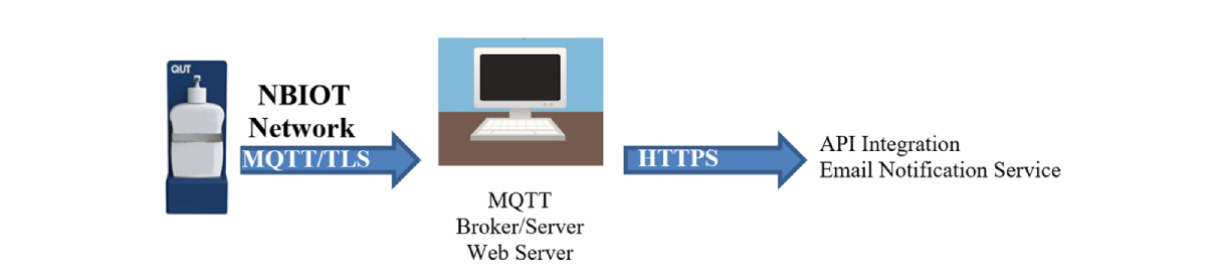
Figure 4. The process flow of data from an Internet of Things (IoT) smart sunscreen station. API: application programming interface; MQTT: